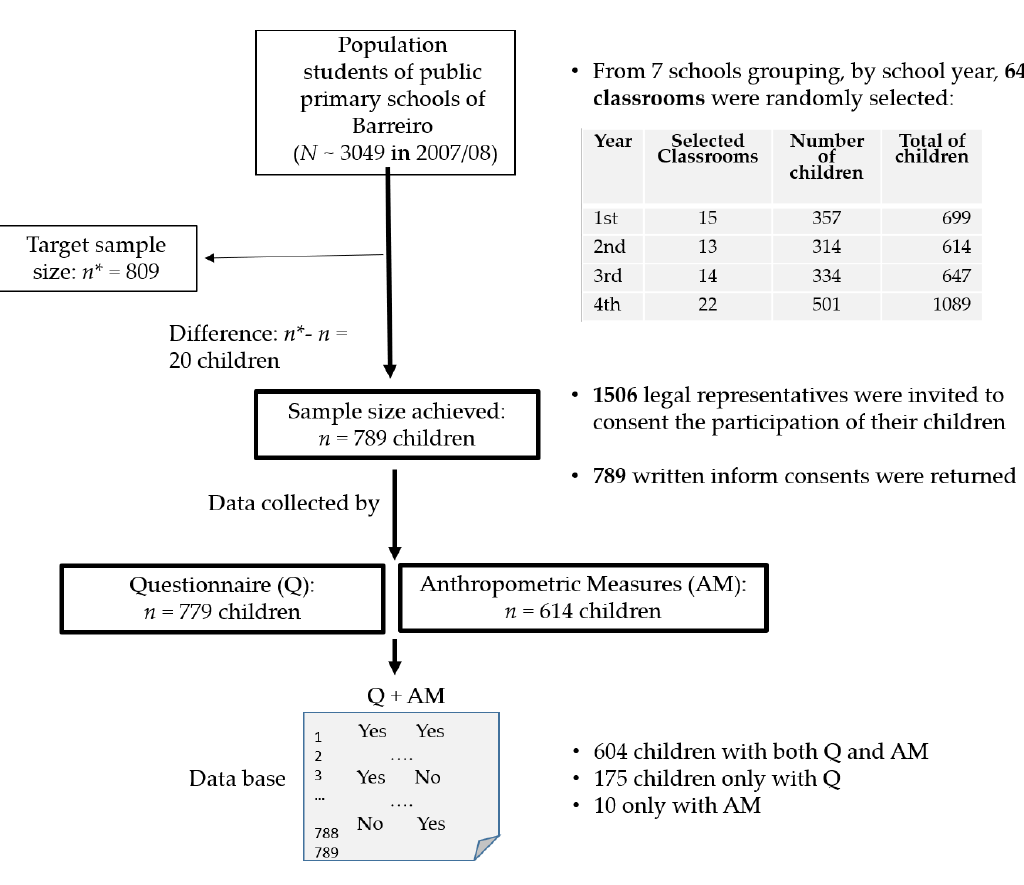
Figure 1. Sampling and data collection of this cross-sectional study.